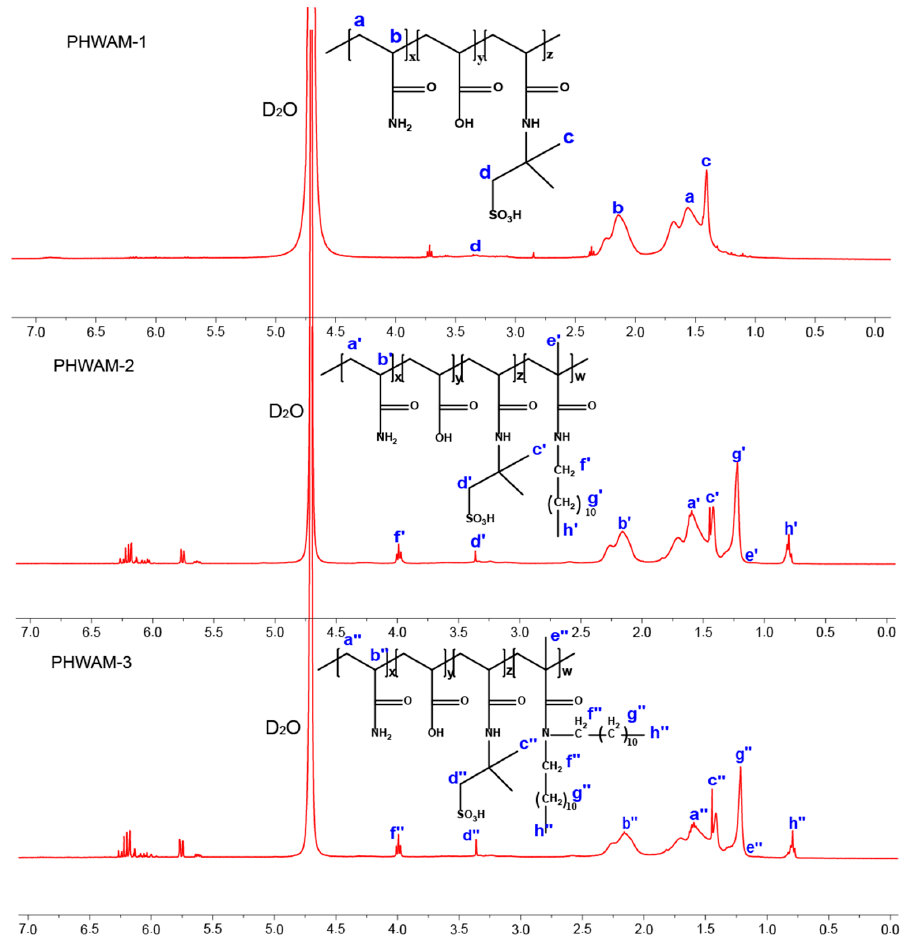
Figure 2. 1 H NMR of drag reducer polymers.